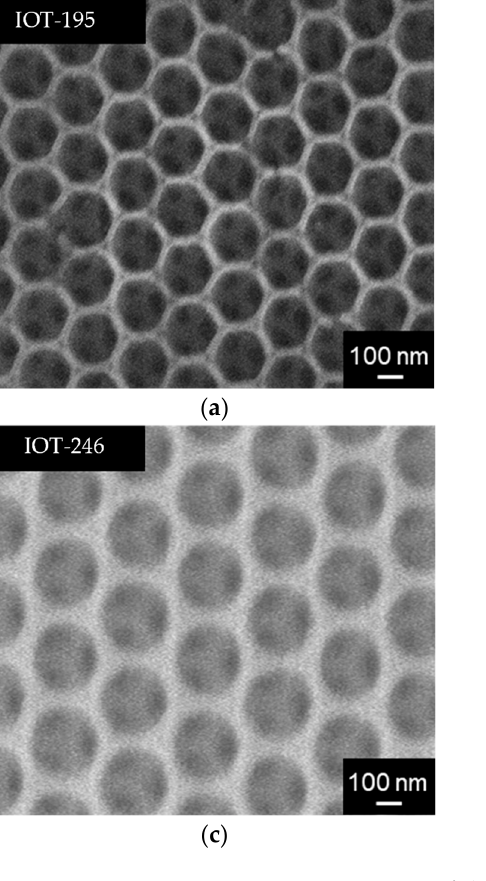
Figure 6. SEM images of: ( a ) IOT-195; ( b ) IOT-226; ( c ) IOT-246; ( d ) IOT-280. Table 3. Summary of IOT-195, IOT-226, IOT-246, and